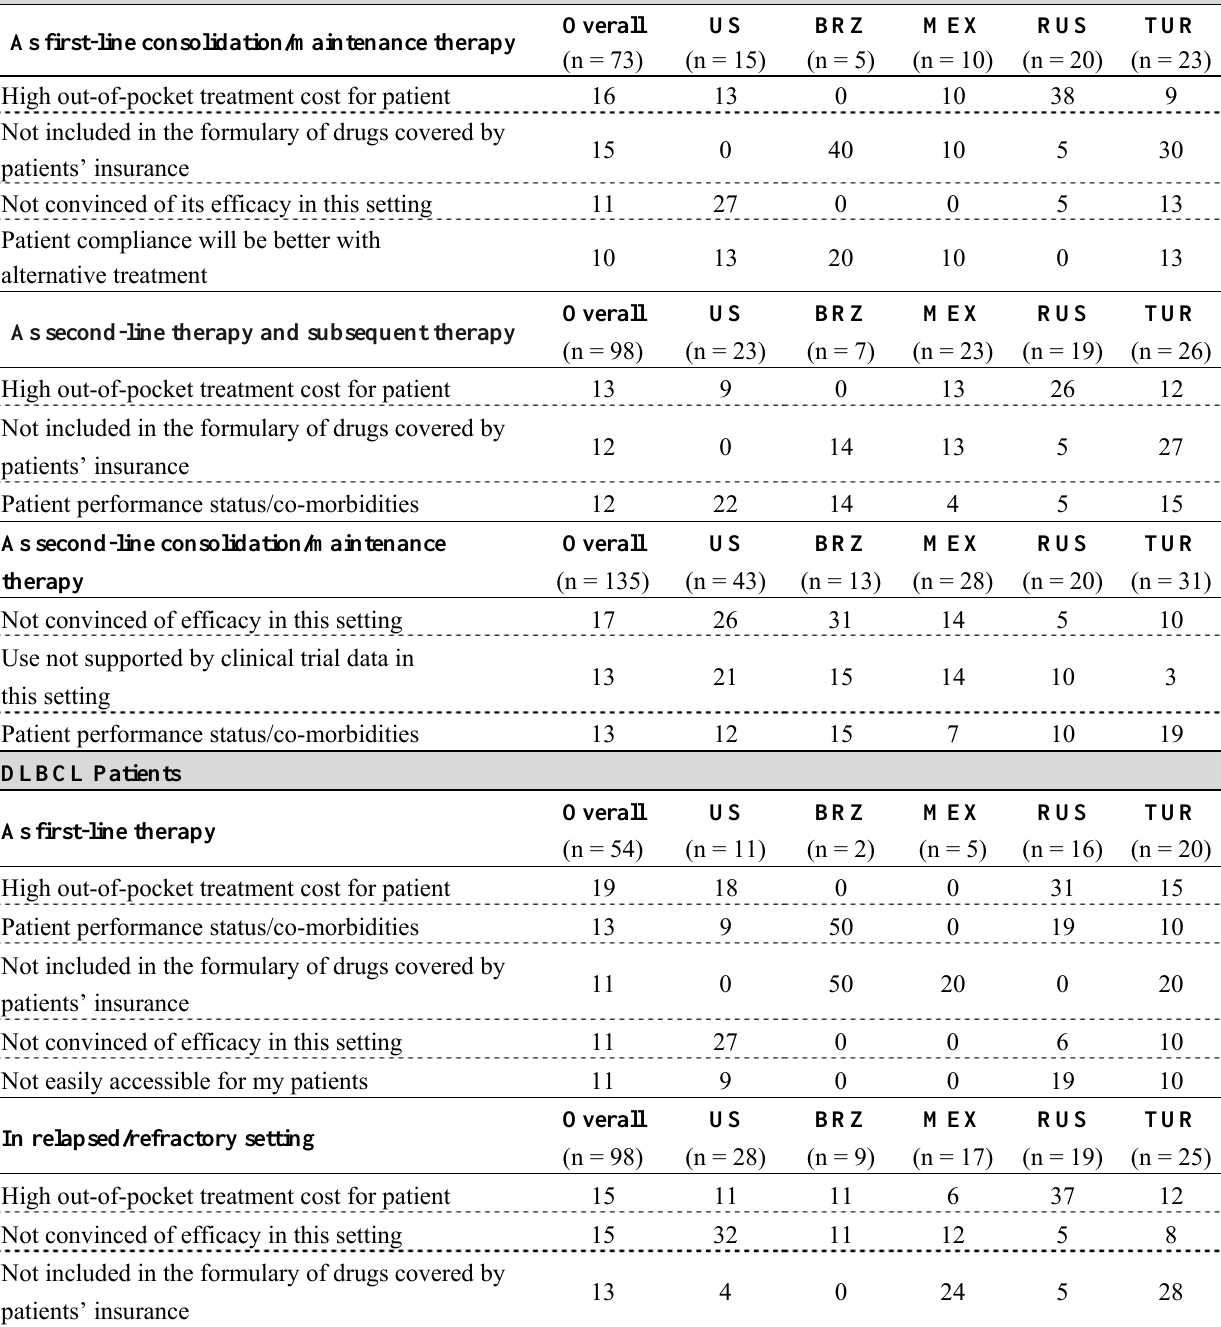
lymphoma; DLBCL = diffuse large B-cell lymphoma; US = United States; BRZ = Brazil; MEX = Mexico; RUS = Russia; TUR = Turkey